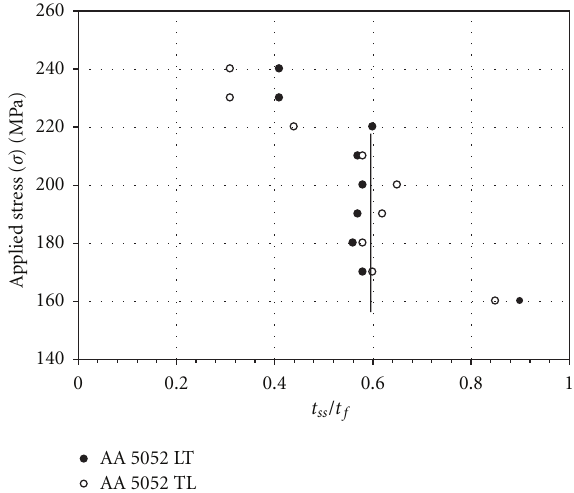
Figure 5: The logarithm of ( t ss / t f ) versus applied stress ( σ ) for A5052-H3 in a 0.5M sodium chloride solution.